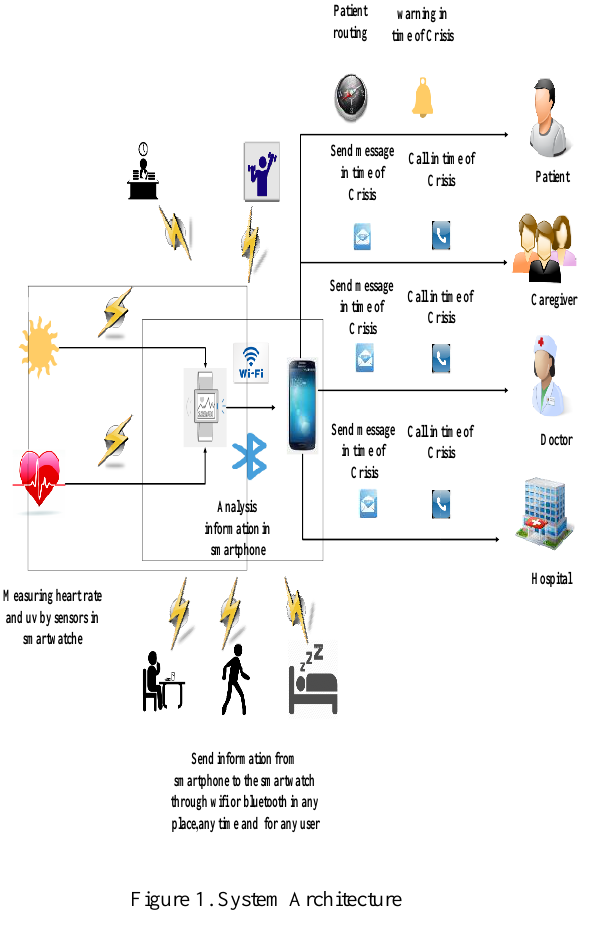
Figure 1. System